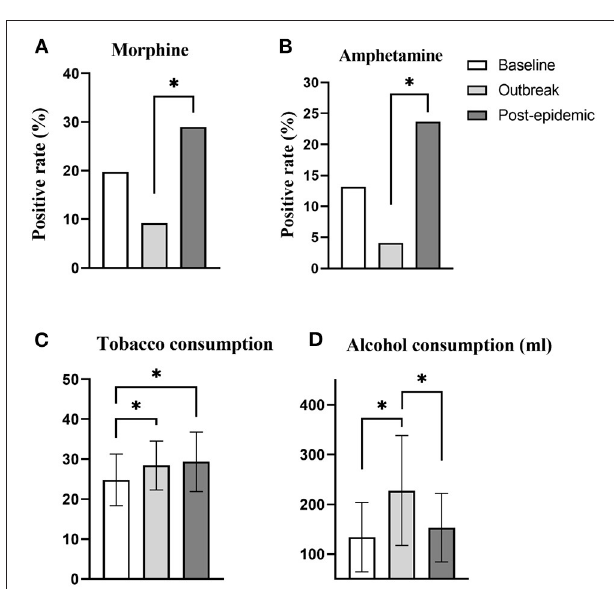
FIGURE 3 | Difference in the use of substances for patients in different time periods. (A) Comparison of the positive rate of morphine urine test in different time periods. When the outbreak, the positive rate of morphine urine test was significantly lower than in the post-epidemic ( p = 0.01). (B) Comparison of the positive rate of amphetamine urine test in different time periods. When the outbreak, the positive rate of amphetamine urine test was significantly lower than in the post-epidemic ( p < 0.01). (C) Comparison of differences in tobacco consumption in different periods. During the outbreak and post-epidemic period, the tobacco consumption of the included patients was significantly higher than the baseline ( p = 0.03, p < 0.01, respectively). (D) Comparison of differences in alcohol consumption in different periods. When the outbreak, the alcohol consumption of the included patients was significantly higher than the baseline and post-epidemic ( p < 0.01, p < 0.01, respectively). * p <